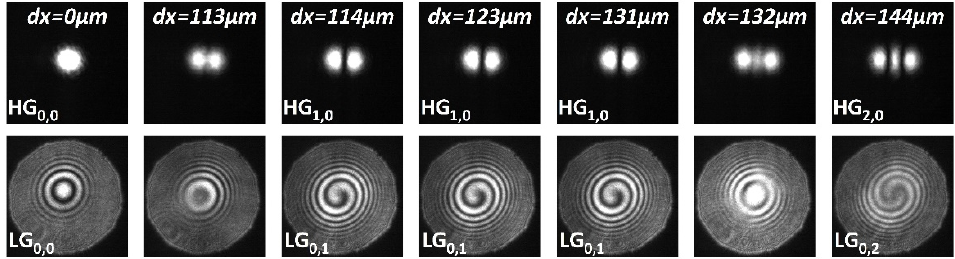
Figure 16. Experiment results of the evolution process from HG 0,0 to HG 2,0 beam and the stable region for the HG 1,0 beam. Table 4. The maximum output power for each vortex mode of single off-axis displacement. Beam